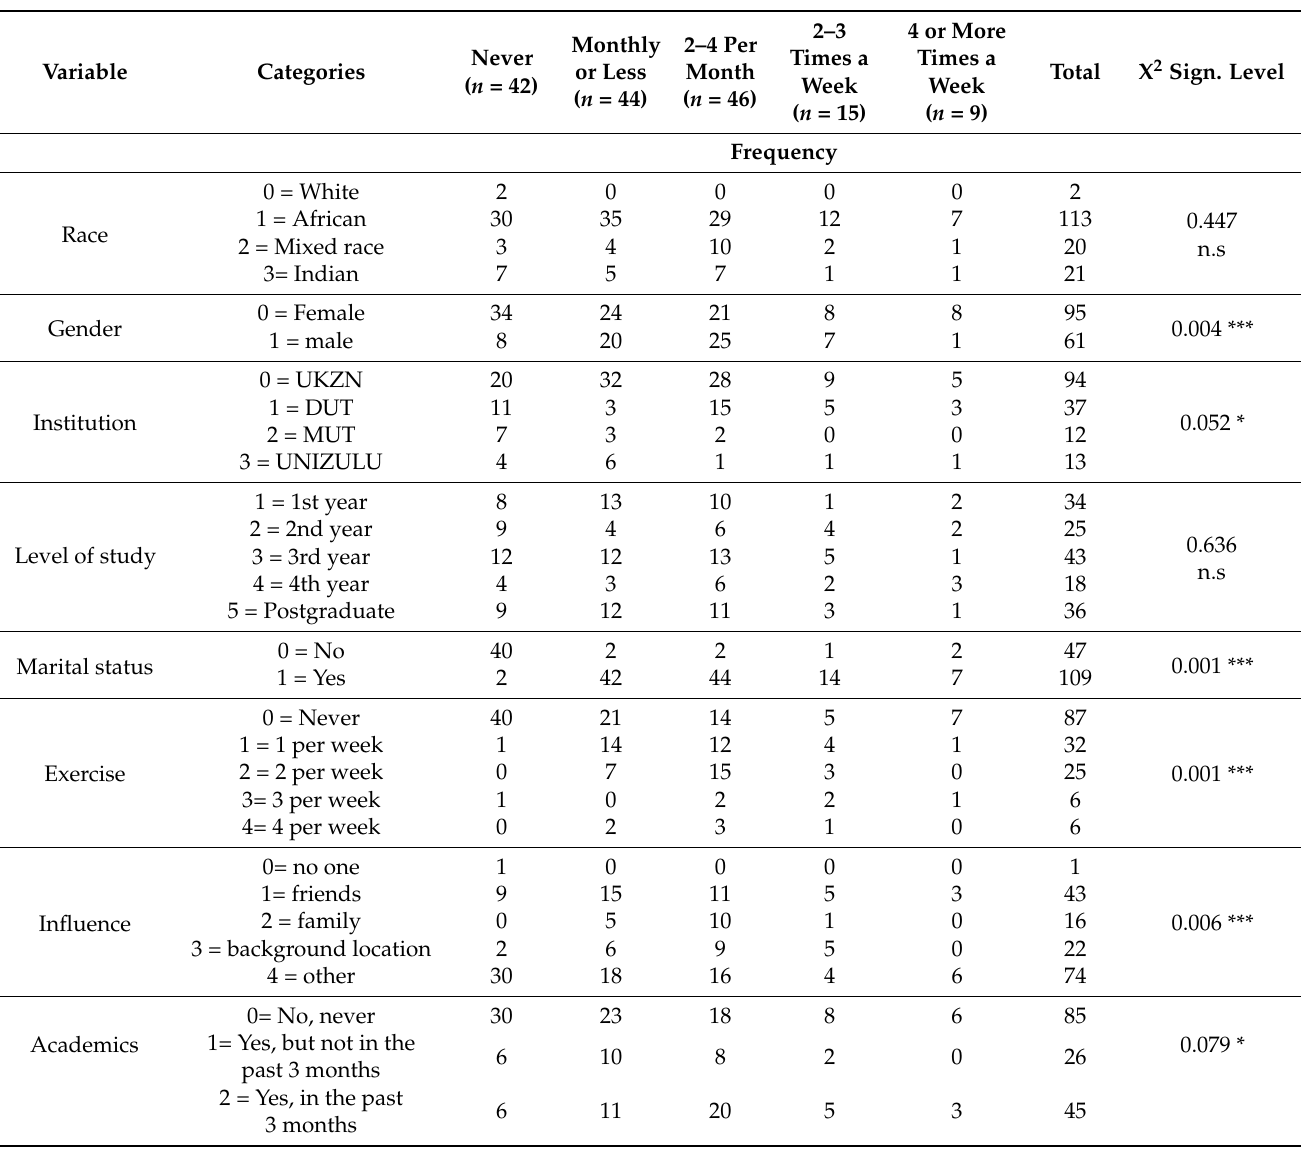
Table 2. Determinants of alcohol consumption among university students for the categorical inde- pendent